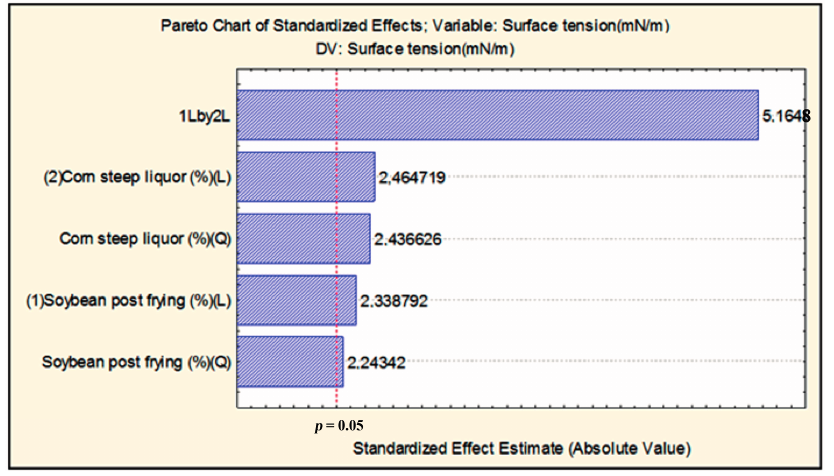
Figure 2. Pareto Chart of standardized effects of the cell-free broth by Cunninghamella echinulata after 96 h of cultivation for the 2 2 full experimental factorial designs on surface tension. The point estimates the statistical significance (at p =